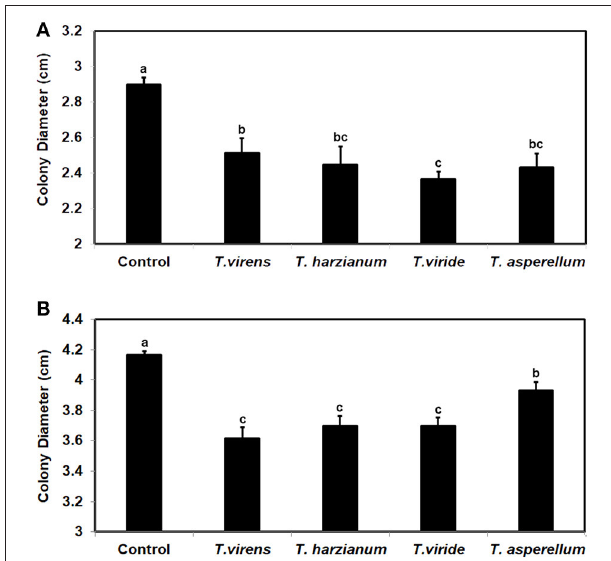
FIGURE 8 | Increased secretion of antifungal metabolites by F. oxysporum in response to Trichoderma VCs. F. oxysporum strains (A) NRRL38499 and (B) NRRL54003 cultured on cellophane membrane overlaid on PDA were co-cultivated with four Trichoderma spp. and un-inoculated PDA (Control) for 40h. After removing the cellophane membrane with F. oxysporum culture, one culture plug of T. virens strain G-41 was inoculated on each plate. Colony diameters after 2 days of incubation are shown. Values shown correspond to the mean SD of data from three replicates. Different letters indicate ± significant differences based on Fisher’s test at P =